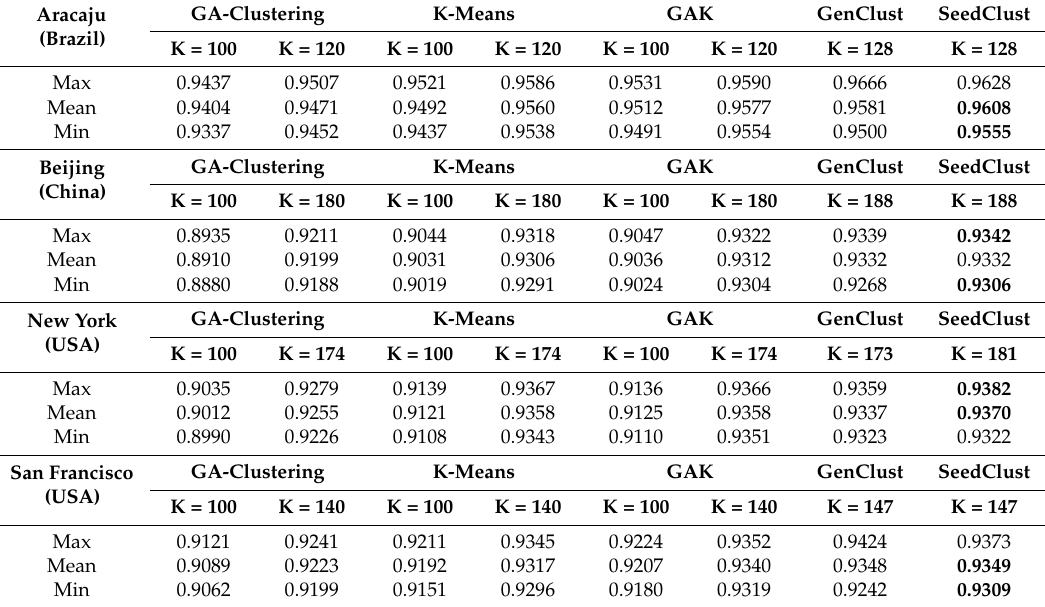
Figure 3. The fitness values of the initial population for the four real-world taxi GPS data sets are obtained by SeedClust (Density), SeedClust (Distance) and GenClust over 20 independence experiments: ( a ) Aracaju (Brazil); ( b ) Beijing (China); ( c ) New York (USA); and ( d ) San Francisco (USA). Table 2. The maximum, mean, and minimum values of Silhouette coefficient obtained by genetic algorithms (GA)-clustering, GAK, K-means, and SeedClust algorithms for 20 different runs for four real-world taxi GPS data sets.